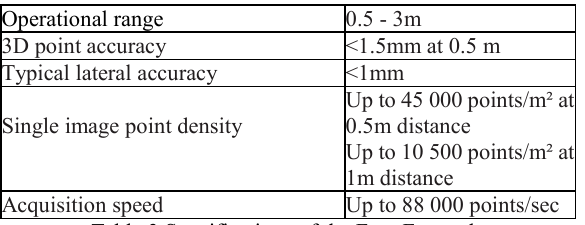
Table 3 Specifications of the Faro